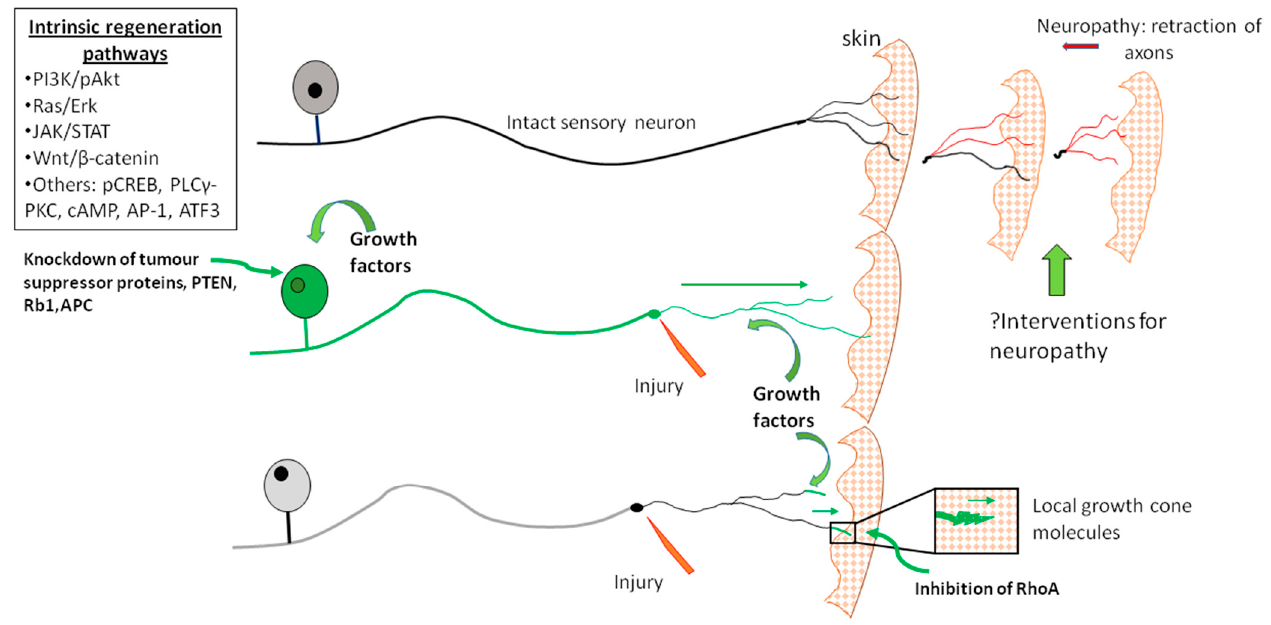
Figure 1. Overall summary of regeneration issues and targets discussed in this